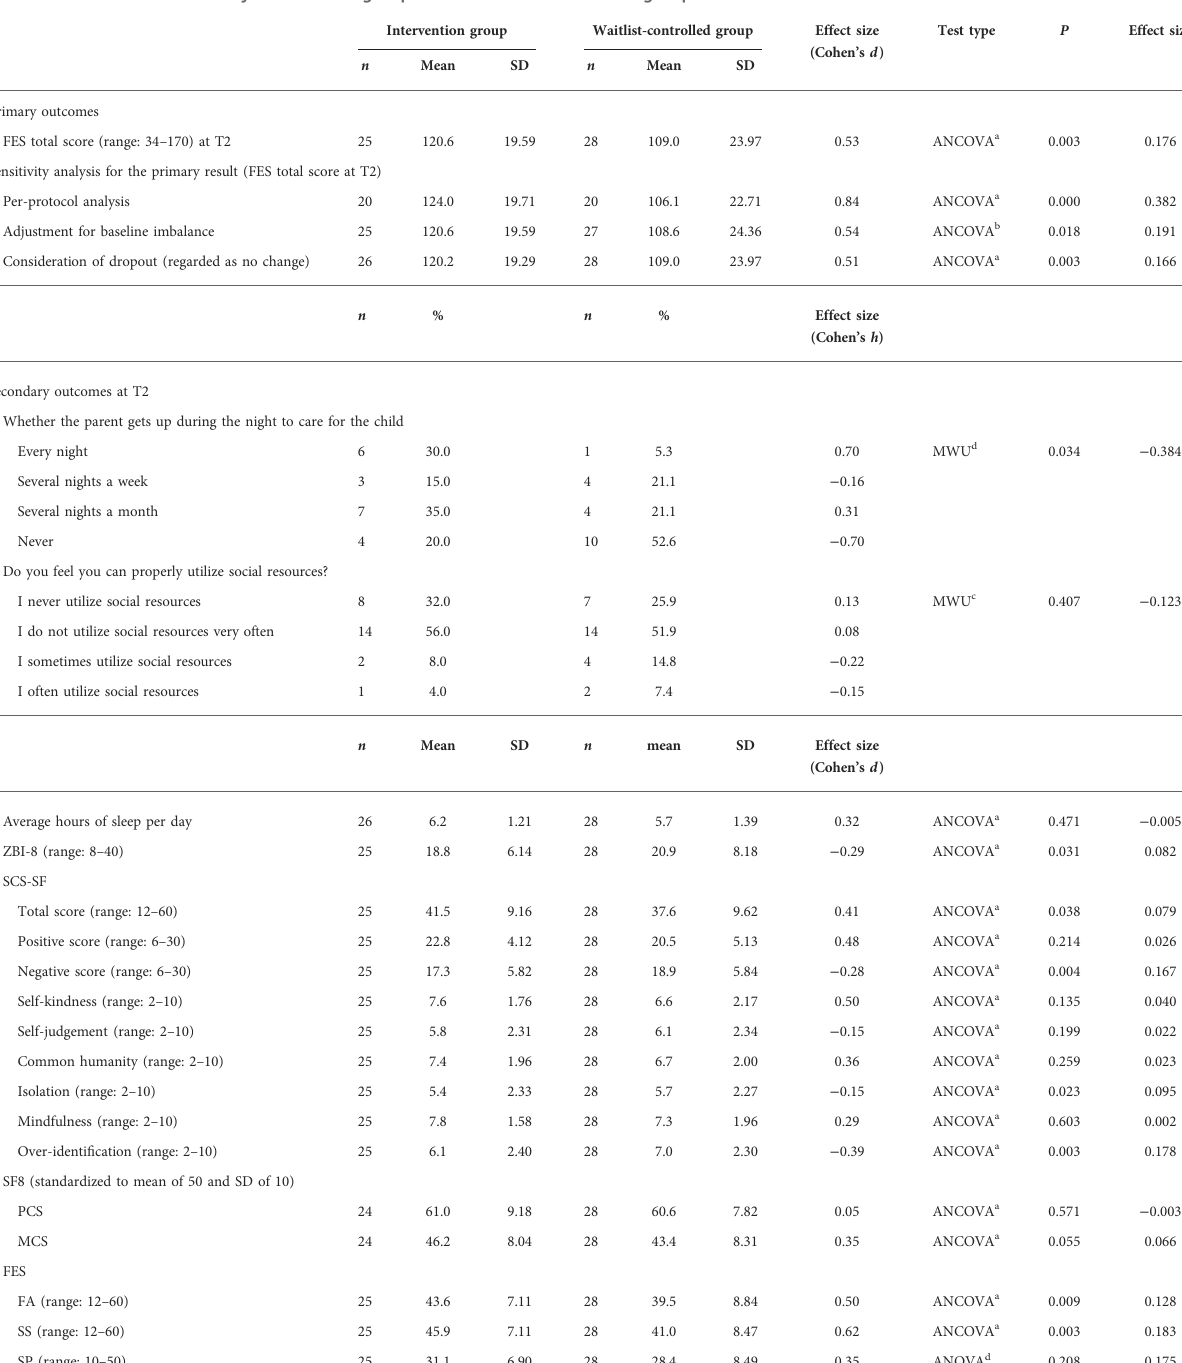
TABLE 3 Outcomes of the early intervention group and the waitlist-controlled group. Intervention group Waitlist-controlled group Effect size (Cohen ’ s d